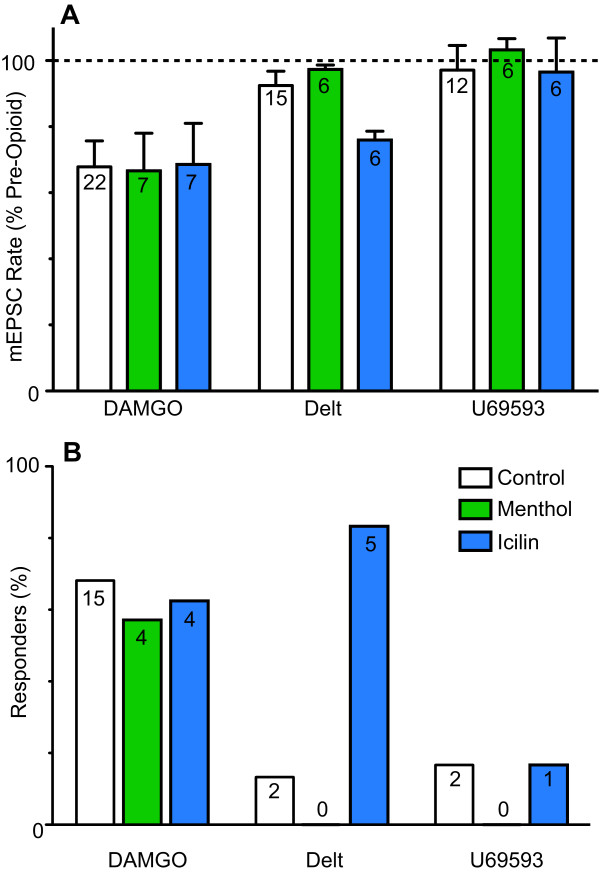
Effect of opioids on basal, and menthol and icilin enhanced miniature EPSCs. (a) Bar chart showing the percentage inhibition of miniature EPSC (mEPSC) rate produced by DAMGO (3 μM), deltorphin-II (Delt, 300 nM) and U69593 (300 nM), expressed as a percentage of the pre-opioid level and averaged across all neurons tested. (b) Bar chart showing the percentage of neurons in which DAMGO, deltorphin-II and U69593 produced a reduction in mEPSC rate of greater than 15%. Data in (a) and (b) are shown for neurons in which opioids were superfused alone, or in the additional presence of menthol (400 μM), or icilin (100 μM). The number in the bars represent (a) the total number of neurons tested and (b) the number of neurons which responded to each opioid.